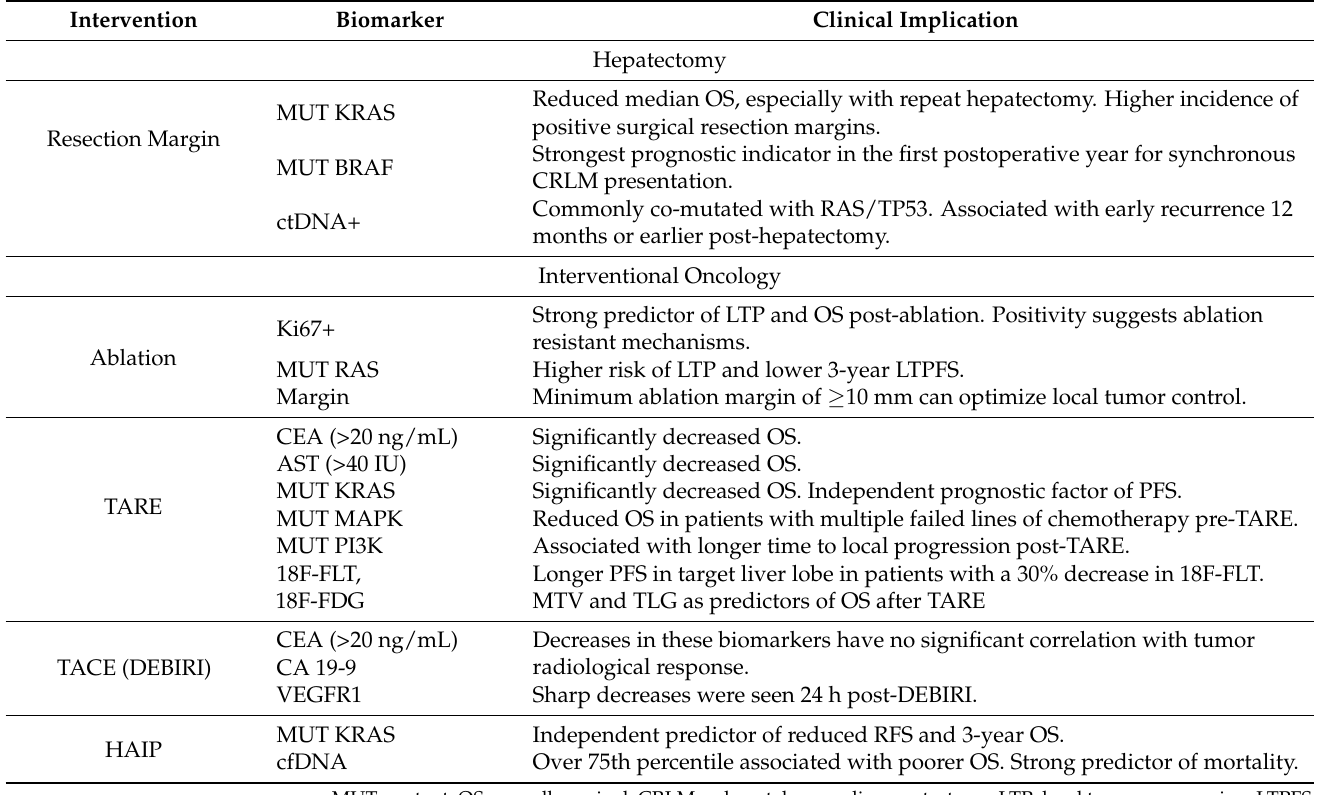
Table 2. Clinical implications of relevant biomarkers with regards to liver directed